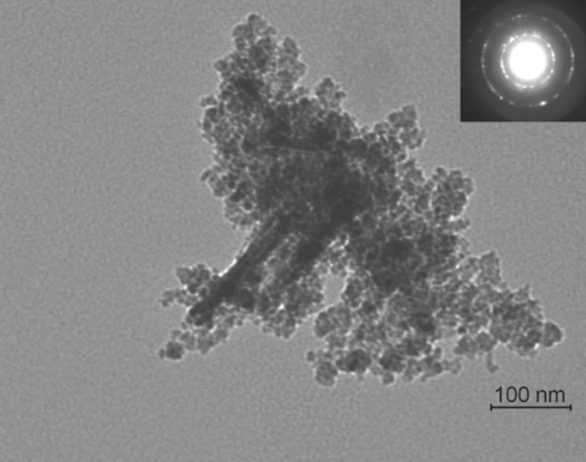
Figure 9: TEM bright-field image and SAED of Fe